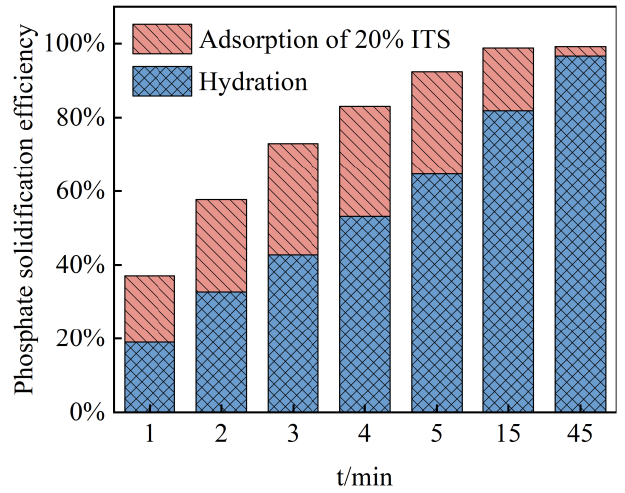
Figure 9. Removal rate of phosphate from slurry by ITs and hydration reaction.